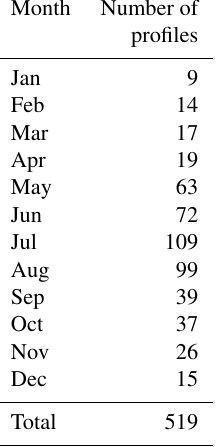
Table 1. Number of nightly mean profiles used to calculate the PCL temperature climatology by month between 1994 and 2013.